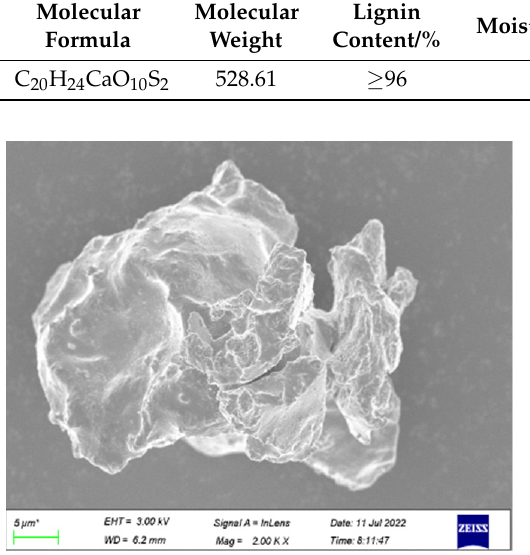
Figure 2. Microstructure of CLS.